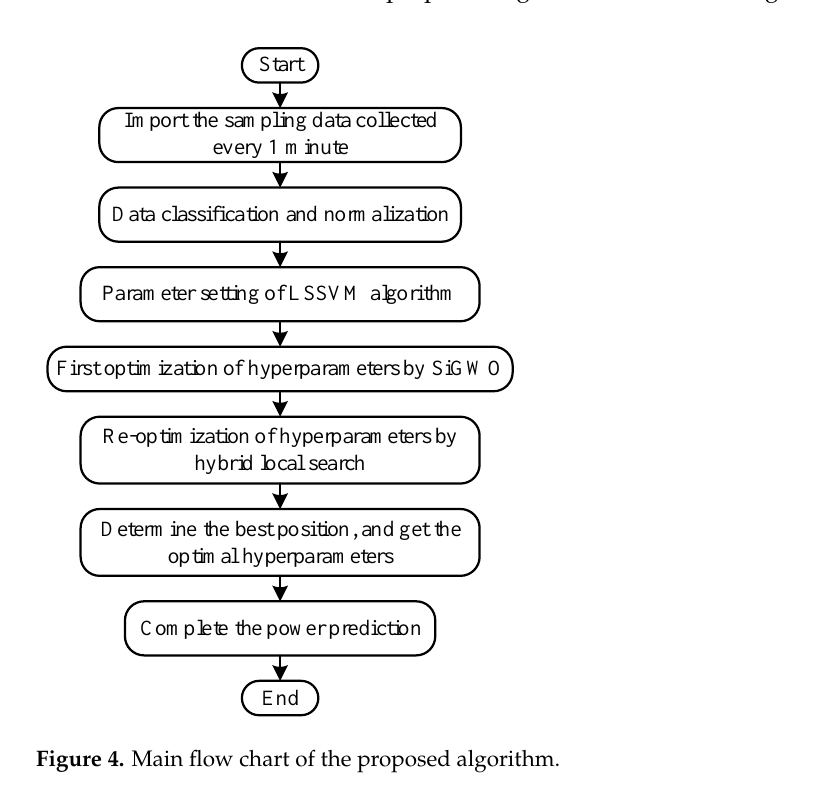
Figure 3. The pseudo code of the hybrid local search.